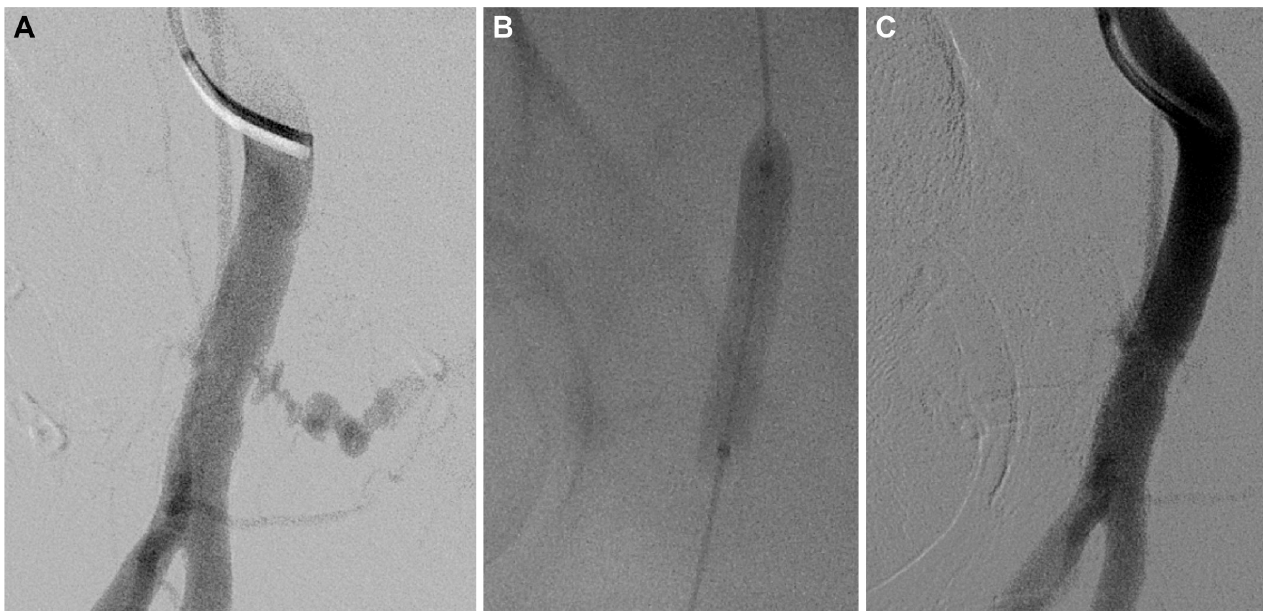
Fig 2. (a) Iatrogenic pseudoaneurysm after failed manual compression. (b) After placing an angioplasty balloon (6 mm in diameter) from a contralateral femoral approach and inflation, thrombin injection was performed under ultrasound guidance. (c) Angiography showing successful thrombosis of the pseudoaneurysm after percutaneous thrombin